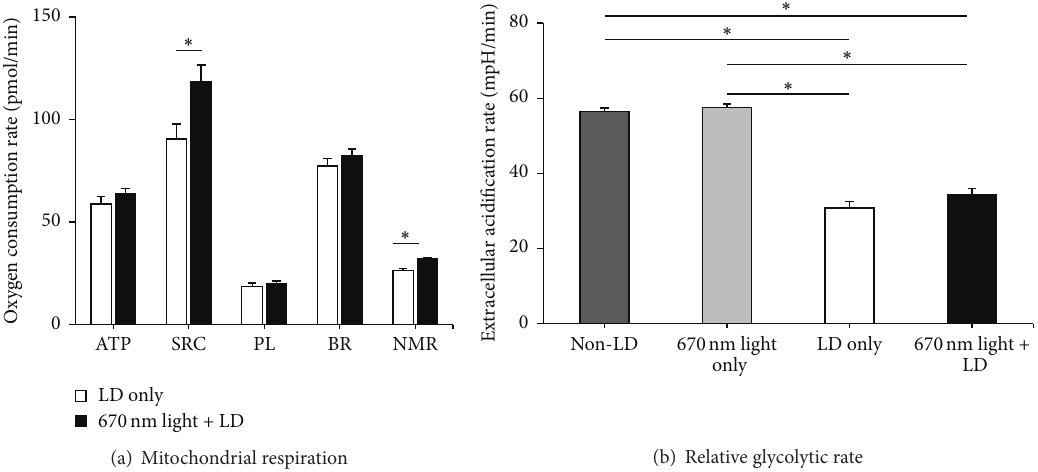
Figure 5: Effect of 9 J/cm 2 of 670 nm light on the mitochondrial respiration of 661 W photoreceptor cells. (a) Under light damage conditions, the cells exhibited an increase in both spare respiratory capacity (SRC) and nonmitochondrial respiration (NMR) when treated with 670 nm light. ATP production (ATP), proton leak (PL), and basal respiration (BR) did not change between groups ( 𝑛 = 4 for both groups; “ ∗ ” denotes significance, 𝑃 < 0.05 ; error bars represent SEM). (b) 670 nm light did not produce a difference in relative basal ECAR measurements in both normal and light damaged conditions. Light damage (LD) significantly decreased the ECAR measurements in cells, both treated and nontreated, when compared to nonlight damaged cells ( 𝑛 = 3 for nonlight damaged cells; 𝑛 = 4 for light damaged cells; “ ∗ ” denotes significance using one-way ANOVA with Tukey’s post hoc test, 𝑃 < 0.05 ; error bars represent